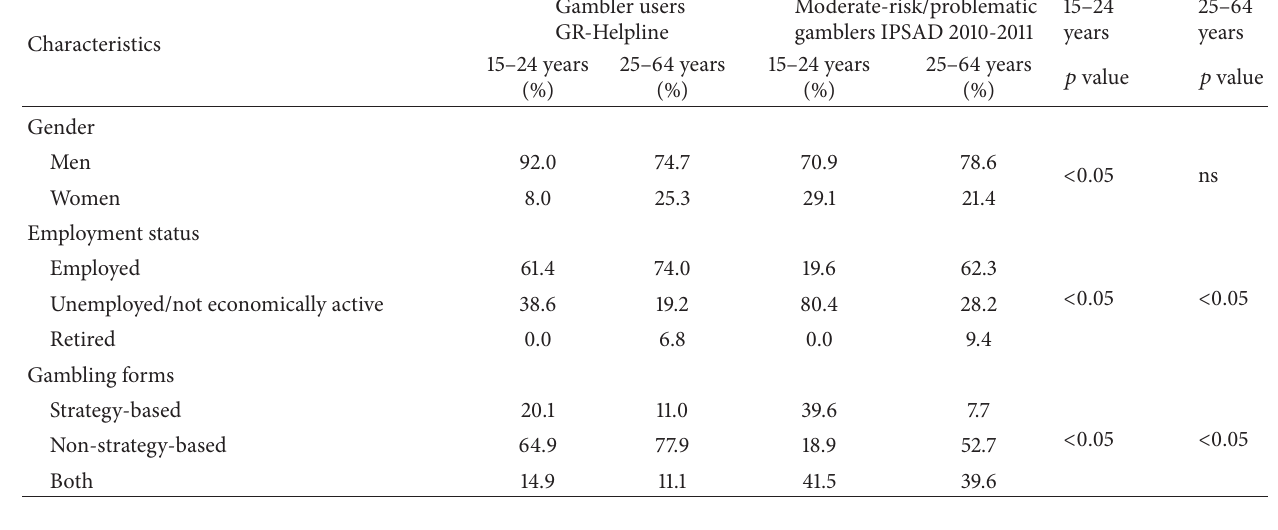
Table 3: Characteristics of gamblers using GR-Helpline and of moderate-risk/problematic gamblers classified by CPGI included in IPSAD 2010-2011 survey.